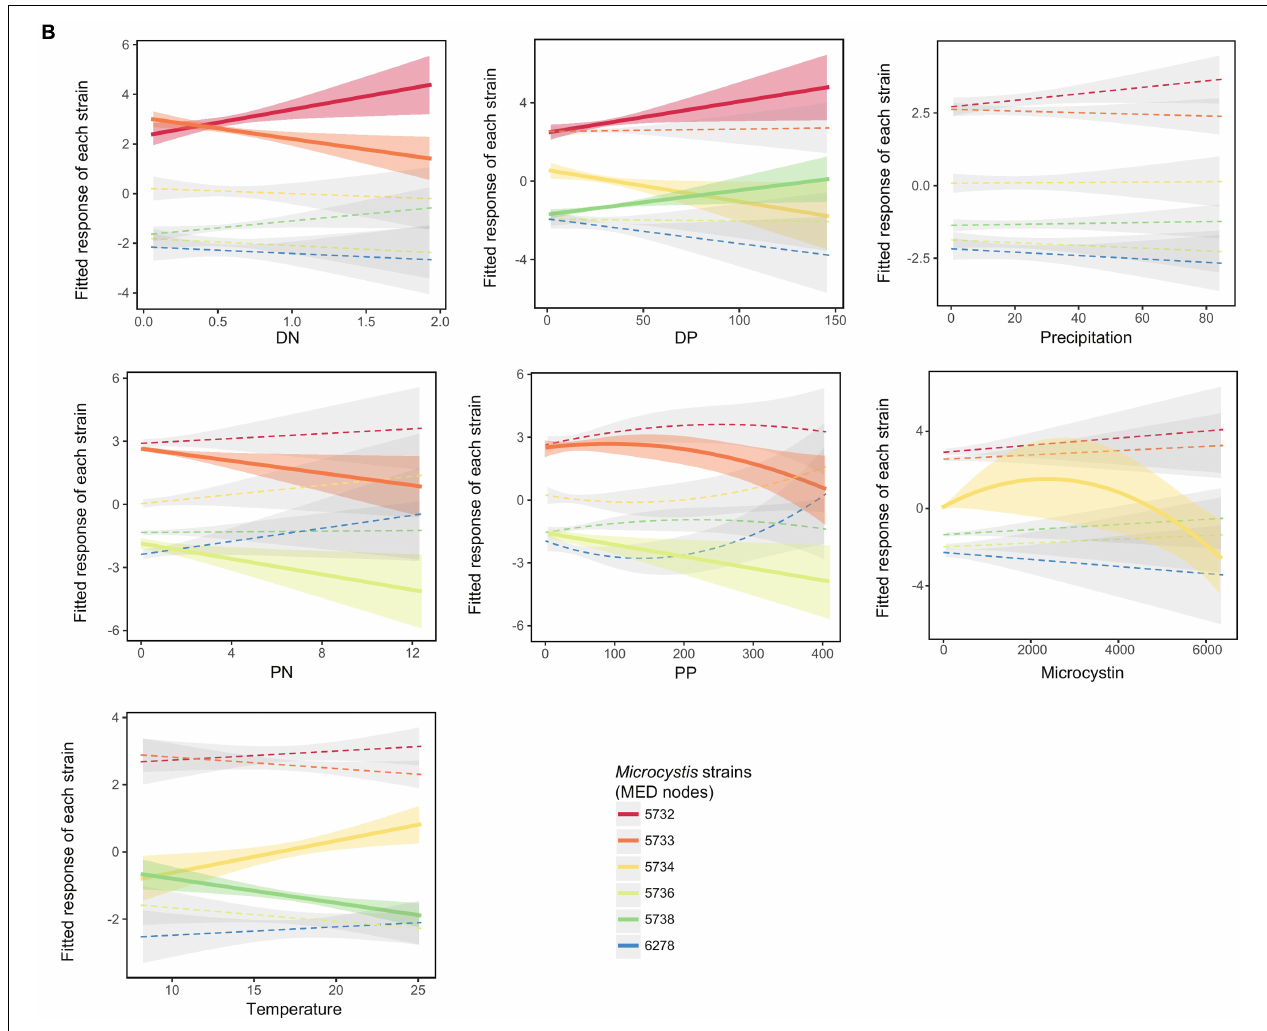
FIGURE 2 | Niche partitioning at the sub-genus level. Best-fit polynomial models of the response of Dolichospermum (A) and Microcystis (B) nodes to abiotic factors. The relative abundance of each MED node (strain) was computed relative to the total number of reads within each genus using the centered-log ratio (clr) transform. Significant relationships are shown by solid lines and colored confidence intervals. In most cases, the degree-1 polynomial (linear model) provided the best-fit (see Supplementary Table S1 for details). For Dolichospermum , only the dominant nodes (observed in at least 70% of samples) are